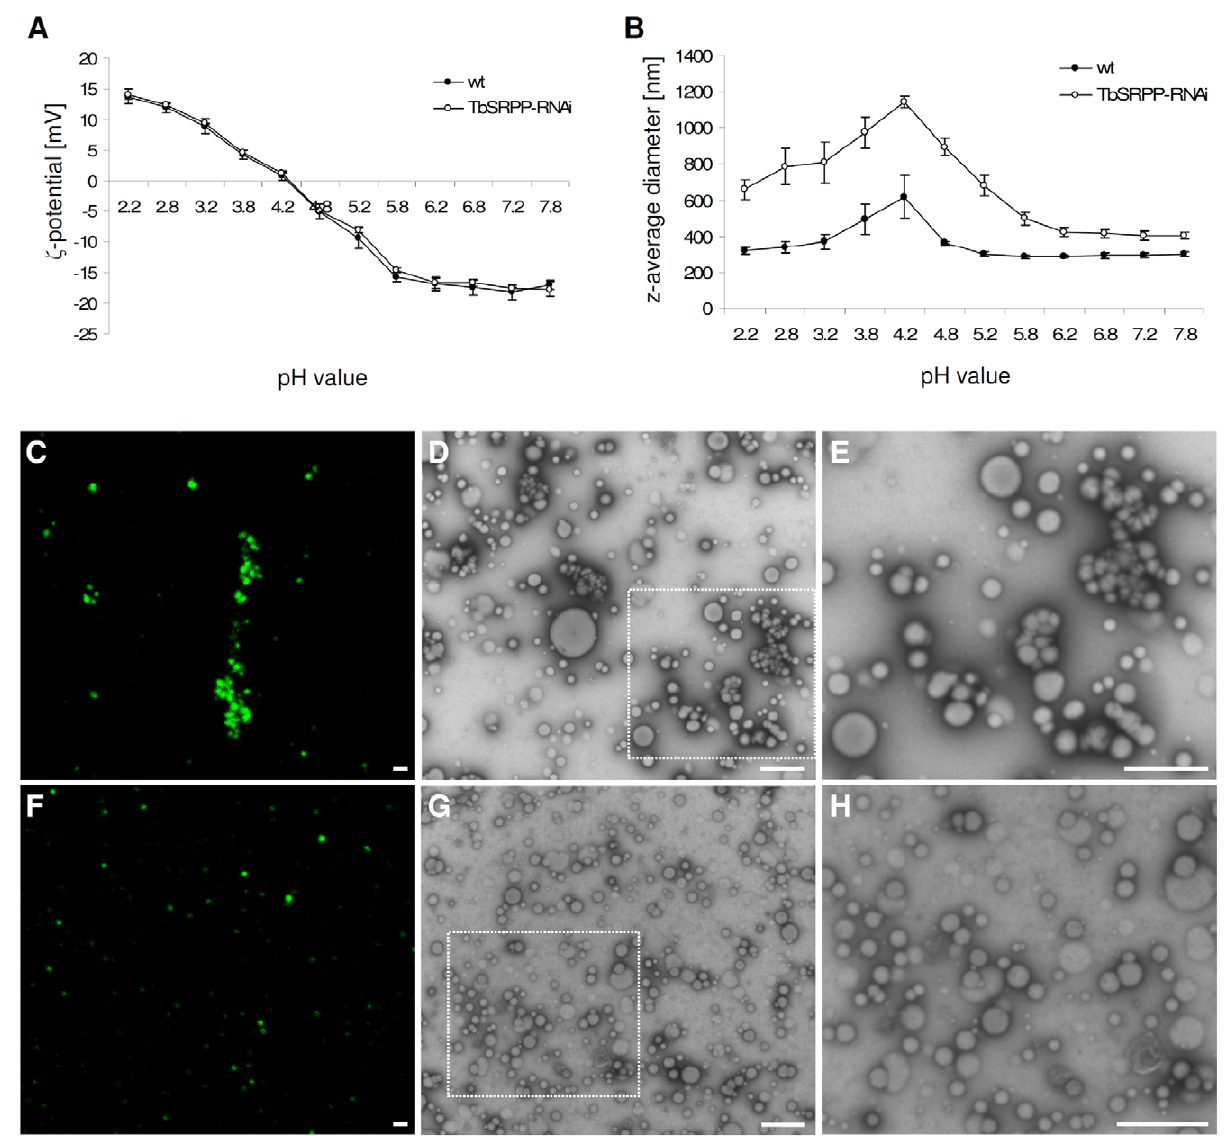
Figure 4. Invitro analysis of the colloidal stability of rubber particles from TbSRPP-RNAi transgenic plants and wild-type plants. A. Measurement of the zeta ( f )-potential of rubber particles from wild-type plants (filled circles) and TbSRPP-RNAi transgenic plants (open circles) suspended in modified rubber extraction buffer (REB) at given pH values. Values represent mean 6 SD of three independent plant lines (S3, S76 and S85) respectively of six wild-type plants (wt). No significant differences were detected among the plants using Students t-test (P, 0.05). B. Measurement of the z-average diameter of rubber particles from wild-type plants (filled circles) and TbSRPP-RNAi transgenic plants (open circles) suspended in modified REB with the indicated pH values. Values represent mean 6 SD of three independent plant lines (S3, S76 and S85) respectively of six wild-type plants (wt). Significant differences have been detected among TbSRPP-RNAi lines and wild-type plants using Students t-test (P, 0.01). C, F. Confocal laser scanning microscopic analysis of isolated rubber particles from TbSRPP-RNAi transgenic plants (C) and wild-type plants (F) that were stained with nile red. D, E and G, H. Transmission electron microscopic analysis of isolated rubber particles from TbSRPP-RNAi transgenic and wild-type plants. D. Micrograph of isolated rubber particles from TbSRPP-RNAi transgenic plant line S3 suspended in modified rubber extraction buffer (REB) pH 7.2 at low and E. higher magnification. G. Micrograph of rubber particles from wild-type suspended in modified REB pH 7.2 at low and H. higher magnification. Enlarged areas are indicated with dashed boxes. Scale bars=1 m